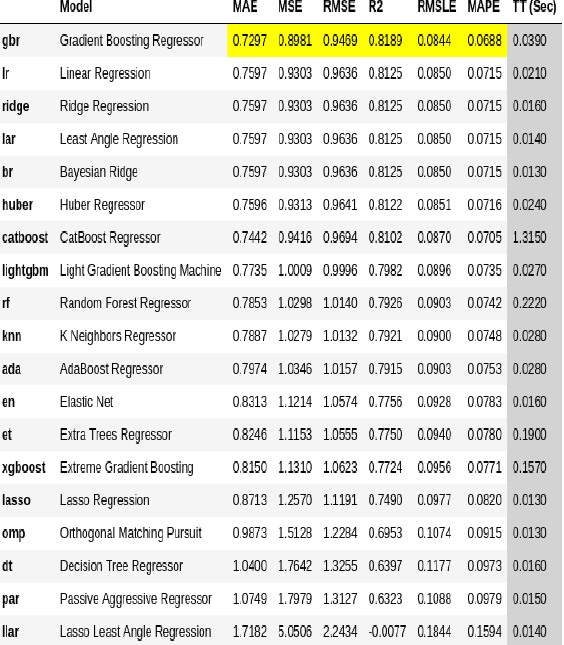
Table 3 . The results and performance of the algorithms used by Pycaret.